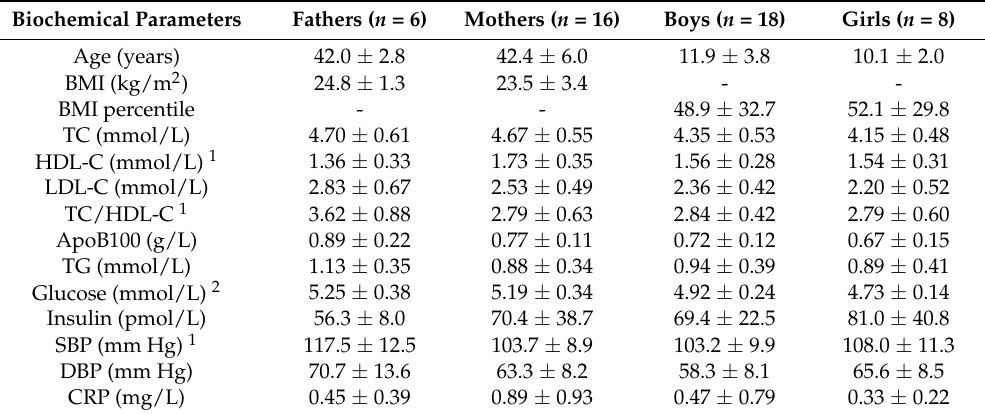
Table 1. Characteristic and biochemical parameters of study subjects. Biochemical